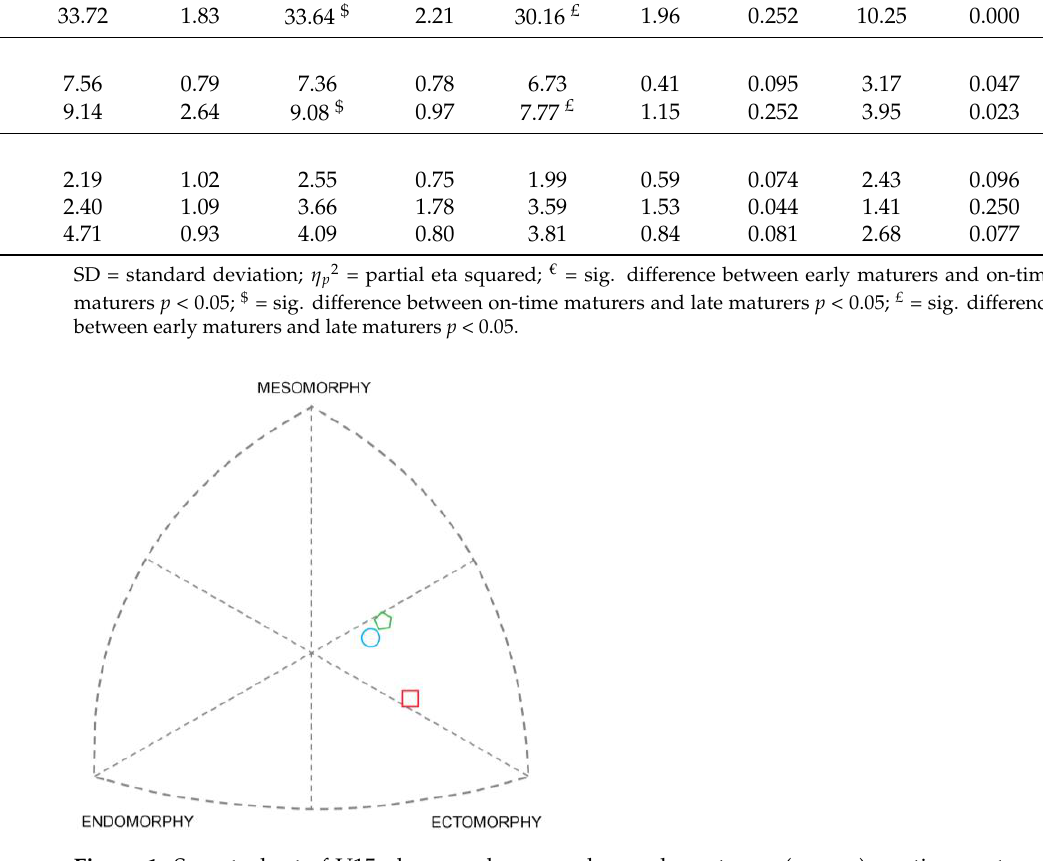
Figure 1. Somatochart of U15 players sub-grouped as early maturers (square), on-time maturers (circle), and late maturers (pentagon).